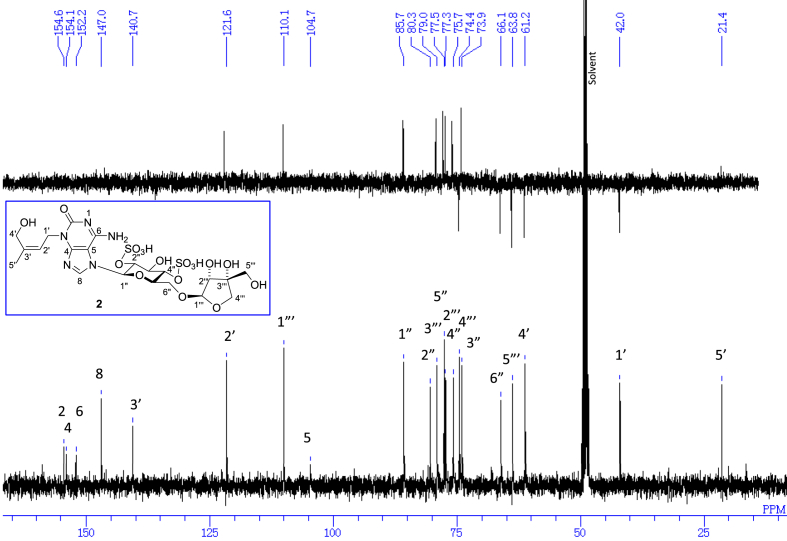
13C NMR and DEPT (100 MHz, CD3OD–D2O, 1:9) of 2.